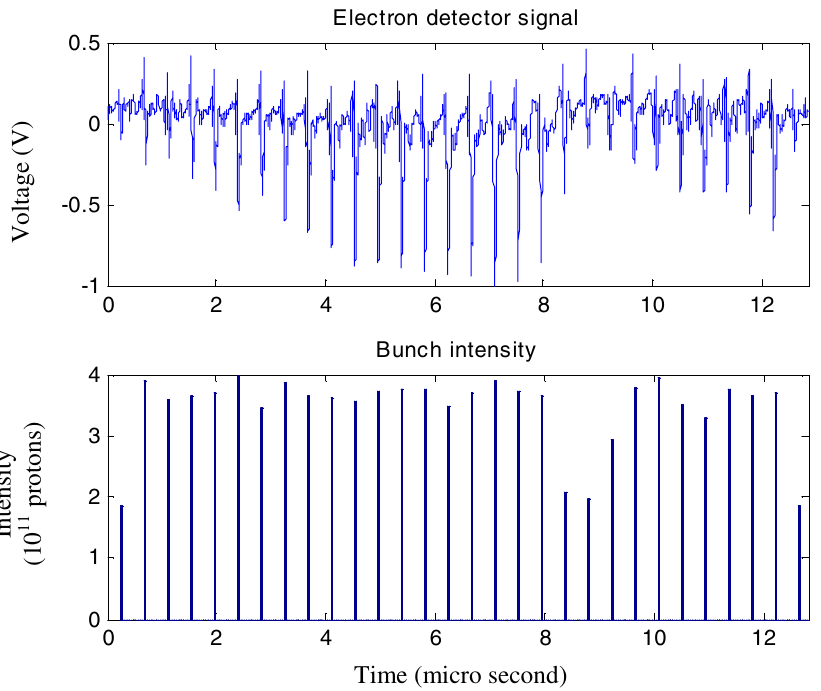
FIG. 3. (Color) Electron multipacting with a bunch spacing of 432 ns at a RHIC interaction region for one revolution period of 12 : 8 (cid:1) s . The 10 ns long bunches, from blue and yellow rings, meet at the location of the electron detector, with an offset of 3 ns in time. The total bunch intensity at the electron detector is also shown, and is due to the added contributions of both